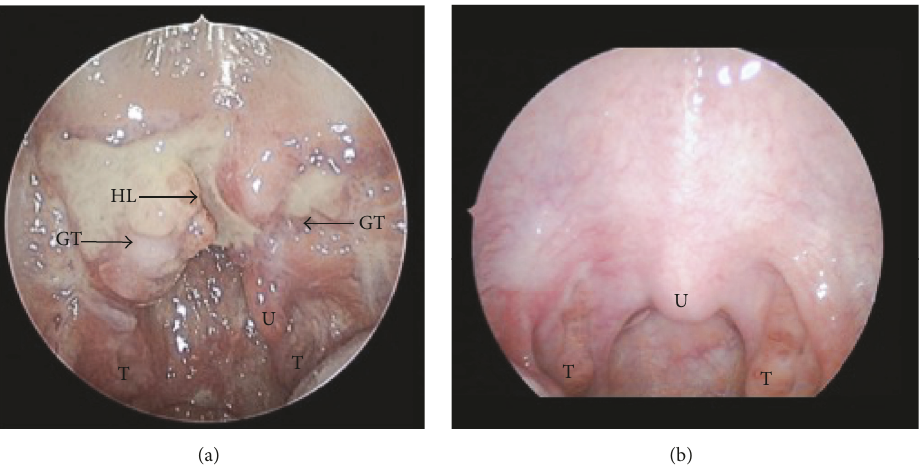
Figure 1: (a) Healing granulation tissue of the soft palate with a deviated uvula; (b) normal palate for comparison; U = uvula; T = tonsil; HL = healing laceration; GT = granulation